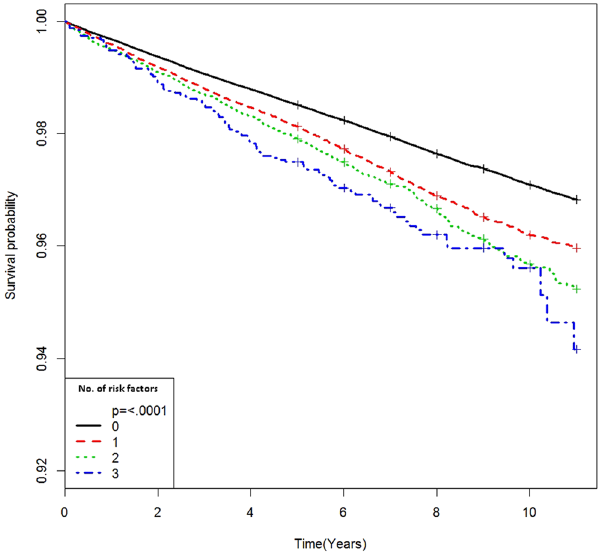
Figure 1. Kaplan-Meier estimates of survival curves for the time to incident psoriasis, stratified by metabolic risk factors. The median follow-up duration was 8.5 years. Subjects were divided into 4 groups according to the number of metabolic factors among diabetes mellitus, hypertension, and hyperlipidemia (log-rank test, P <